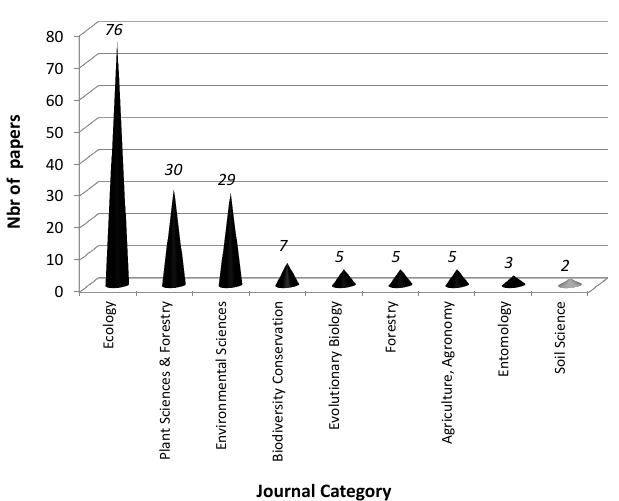
Figure 3. Total number of papers on secondary dispersal in dry- lands published between 1974 and 2013 and classified by journal categories. The graph underlines the anecdotal number of papers (2) published in soil-science-related journals (grey cone).